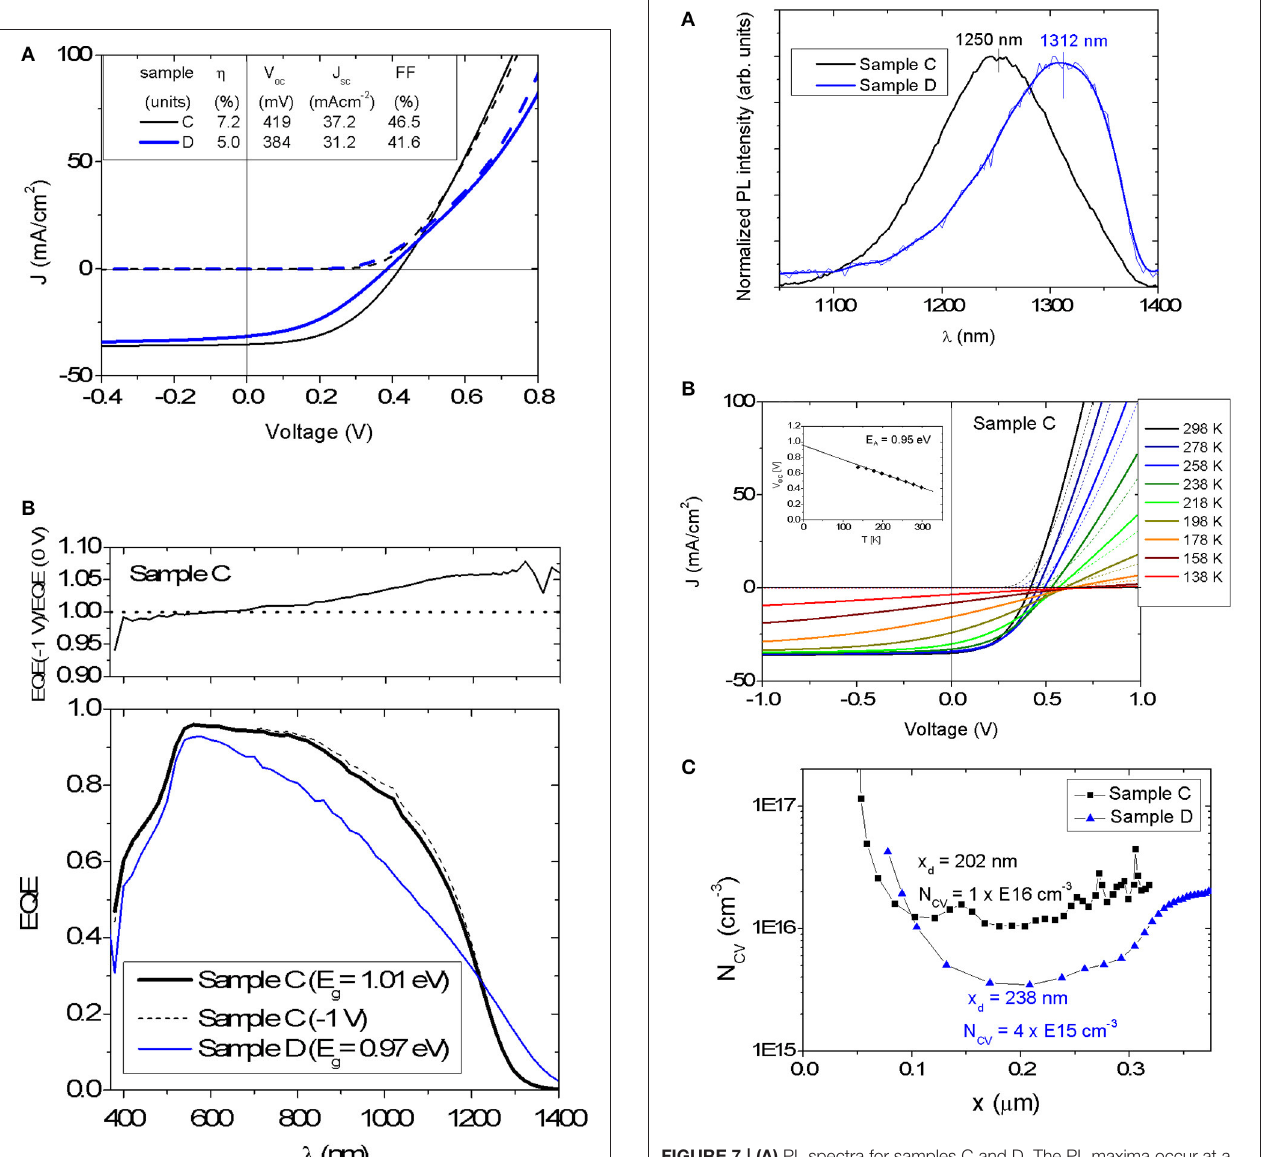
FIGURE 7 | (A) PL spectra for samples C and D. The PL maxima occur at a smaller energy value than the band gap (as determined from the EQE curve) for both samples. (B) Temperature dependent J-V measurement (dark curve—dotted line, light curve—solid line) of device C. The inset shows a linear fit of V oc that can be extrapolated to an intersection value E A = 0.95eV, which is close to the estimated E g = 1.01eV, as determined by EQE. (C) N CV vs. x for the devices C and D extracted from C-V measurements. The values of depletion width x d and N CV at 0V are